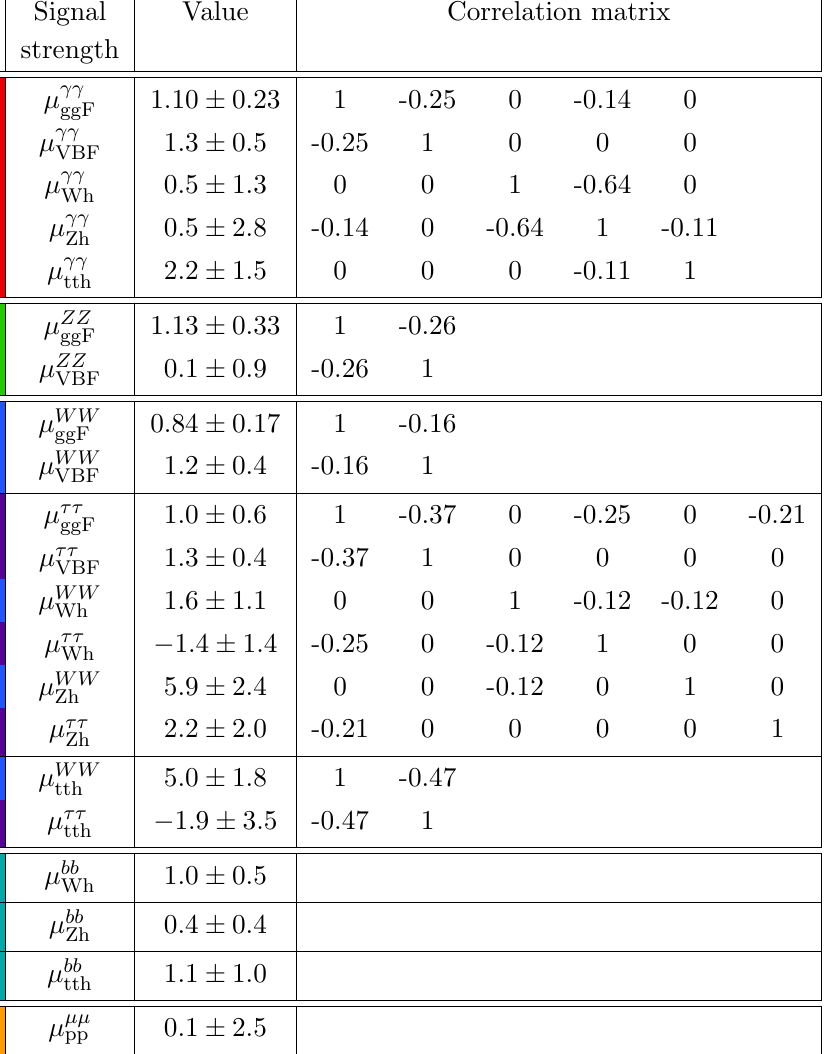
Table 2 . h signal strengths from table 8, table 13 and (cid:12)gure 27 of the o(cid:14)cial ATLAS and CMS combination for Run 1 [3], based on 25 fb (cid:0) 1 of integrated luminosity. We neglect correlations below 0.1. The colours in the (cid:12)rst column indicate the decay category in (cid:12)gures 1 and 2.